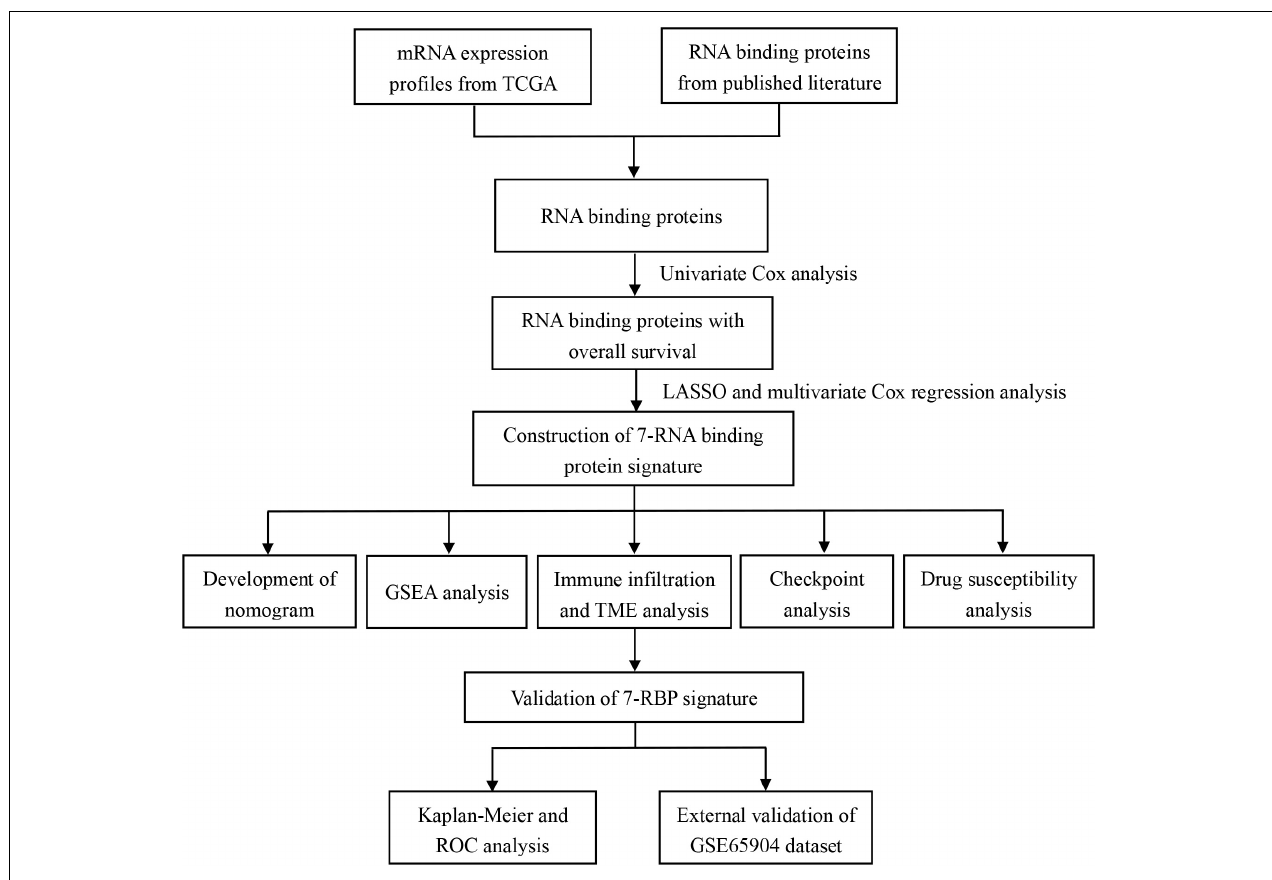
FIGURE 1 | Flow diagram showing the design of the